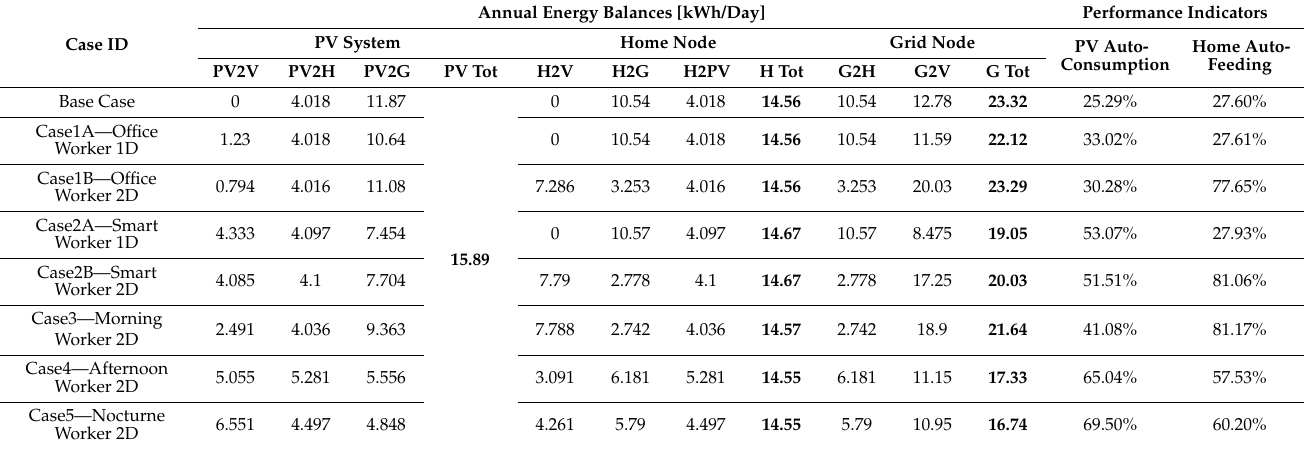
Figure 23. Energy balances at the main nodes ( left ) and performance indicators ( right ) for Case5 — NW 2D. Table 2 provides a summary of the main results obtained through the simulations. Table 2. Summary of the main results for all the simulated conditions.